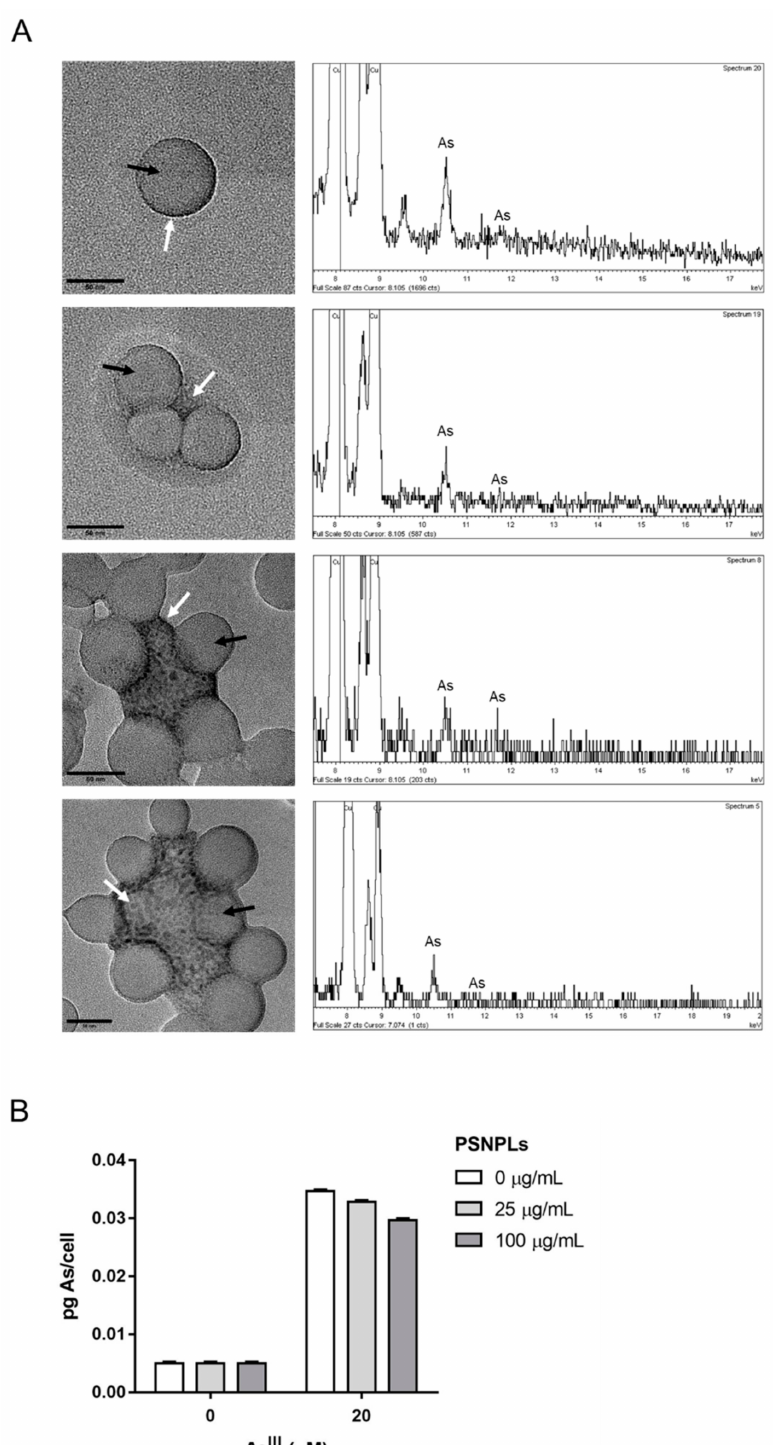
Figure 3. Determination of the interaction between PSNPLs and As III , and the As III uptake by PTP cells. ( A ) Representative TEM images with their respective energy-dispersive X-ray EDX spectra indicate the chemical elemental characterization. Arrows point to the round-shaped PSNPLs (black) or the areas where arsenic was detected (white) ( B ) Quantification of the arsenic internalization by PTP cells. Arsenic was not detected in control samples; thus, results are arbitrarily represented as 0.005 pg of As III . Data are represented as mean ± SEM and was analyzed by the Student’s t